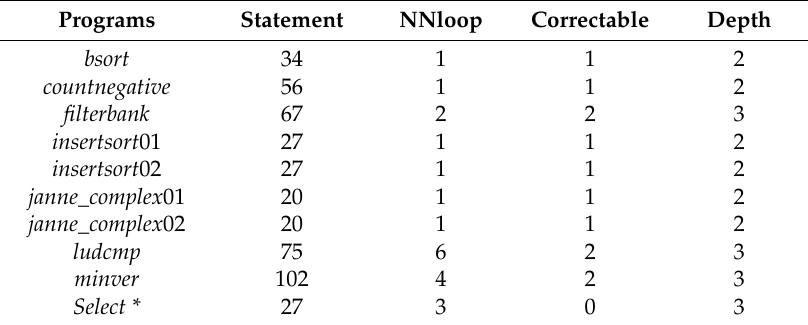
Table 2. Experimental